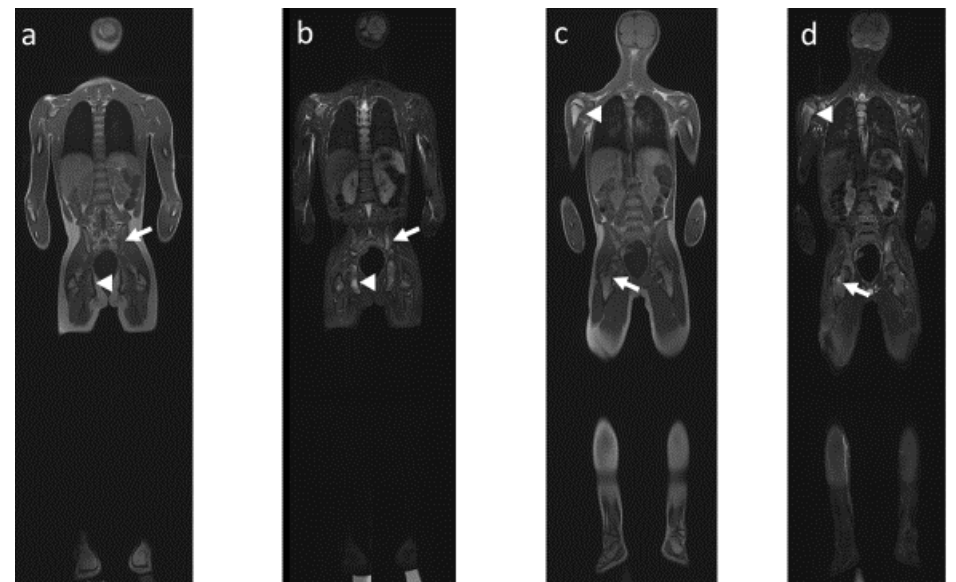
Figure 4. Whole body MRI, 12-year-old boy with confirmed CRMO. Coronal plane in ( a ) T1-weighted sequence and ( b ) STIR-weighted sequence showing bone marrow edema in the left iliac wing (arrow) and the right pubic ramus (arrowhead). Coronal plane (same exam) in ( c ) T1-weighted sequence and ( d ) STIR-weighted sequence showing bone marrow edema in the metaphysis of the right upper femur (arrow) and the metaphysis of the right upper humerus (arrowhead).